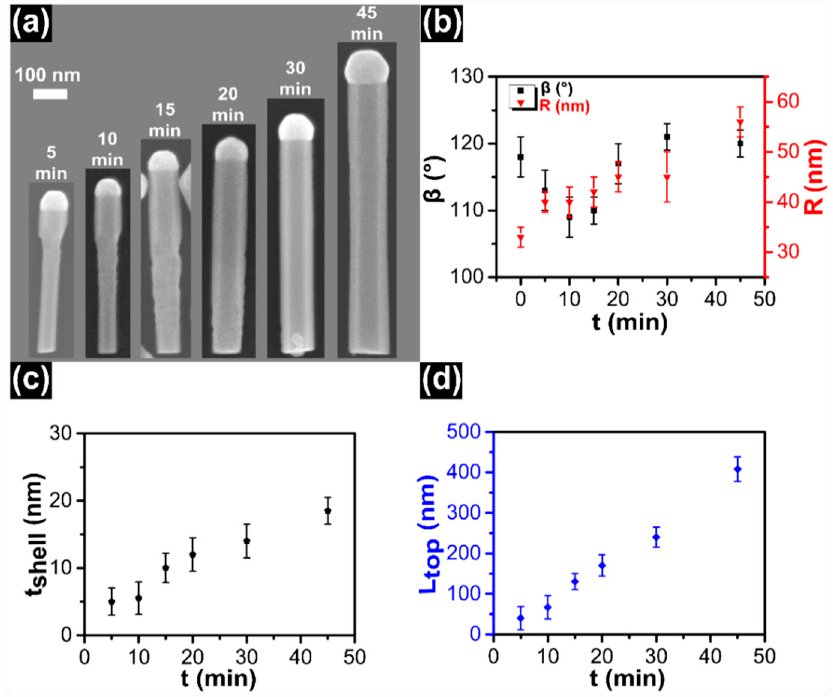
Figure 3. ( a ) SEM images of representative InSb/InAs QD NWs, obtained with fixed line pressures F In = 0.30 Torr, F As = 0.30 Torr, at T InAs = 440 ± 5 °C, while the growth time of InAs top segments varies from 5 min to 45 min as indicated in each panel. ( b ) The evolution of contact angle of In droplets on the top of NWs and the base radius of NP as a function of growth time. At time t = 0 min they correspond to contact angle and base radius at the end of InSb segment growth. ( c ) Evolution of InAs shell thickness around the InSb QD as a function of growth time. ( d ) Evolution of length of InAs top segments as a function of growth time. The symbols represent an average value of each sample obtained by measuring ~25 NWs and error bars represent the standard deviation of the average.